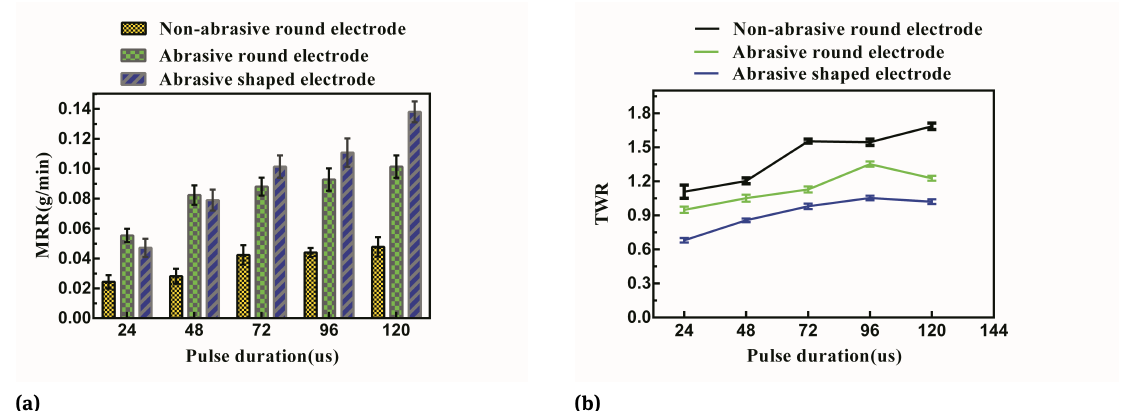
Figure 9: Influence of pulse duration on MRR and TWR (applied voltage = 120 V, peak current = 25 A, duty cycle = 1:5, rotary speed = 2400 rpm).